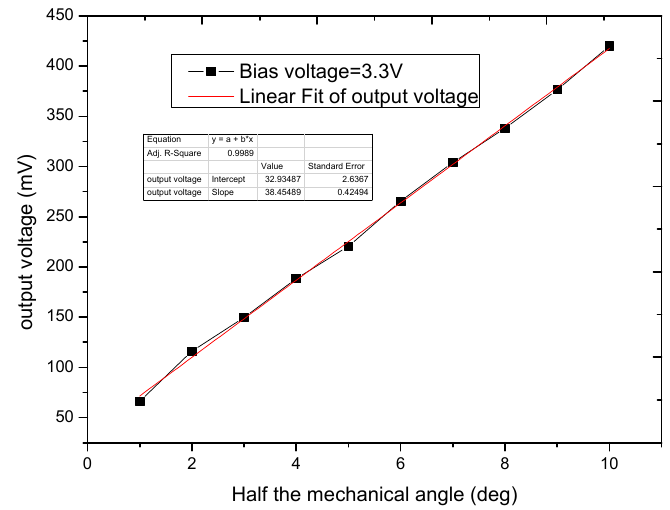
Figure 9. Sensor signals as the function of the mirror rotation angle of the four-terminal piezoresistive element.